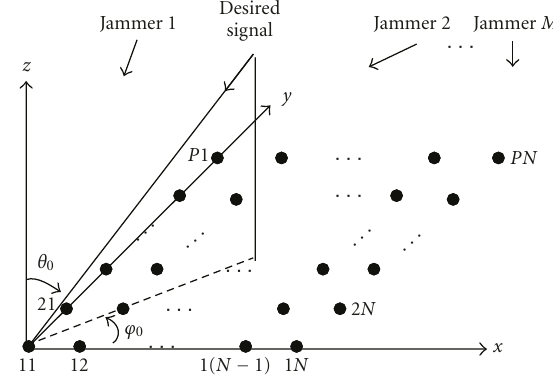
Figure 1: URA with N × P